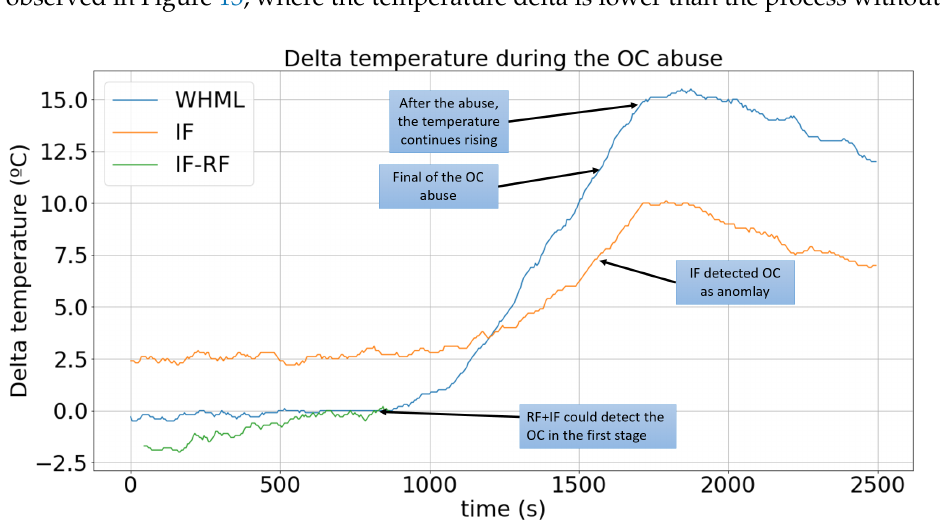
Figure 13. The behavior of the delta temperature under the OC abuse experiments without ML and with the IF and RF. The time of the IF-RF’s application is shorter than the others because the model could identify the OC in the first